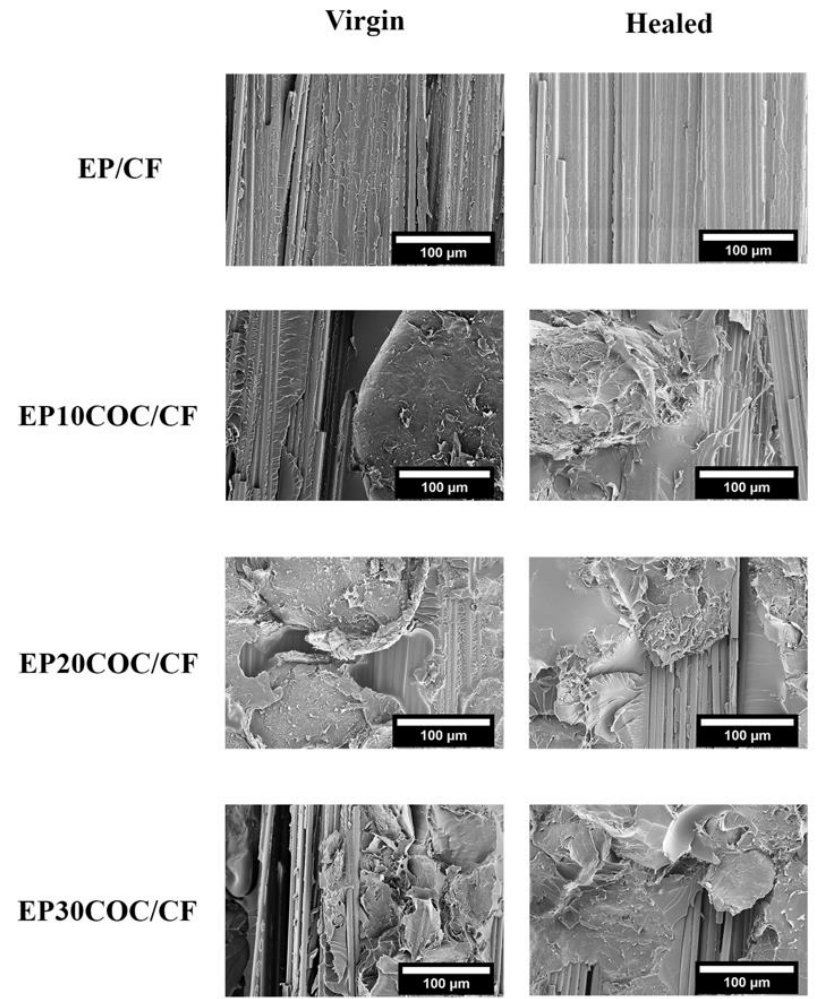
Figure 7. SEM images of Mode I opened DCB specimens before and after healing process.